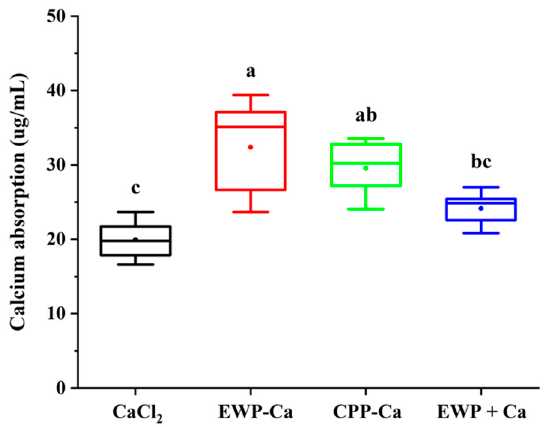
Figure 5. The calcium absorption of CaCl 2 , EWP-Ca, CPP-Ca, and EWP + Ca. The different letters indicate a significant difference ( p < 0.05).